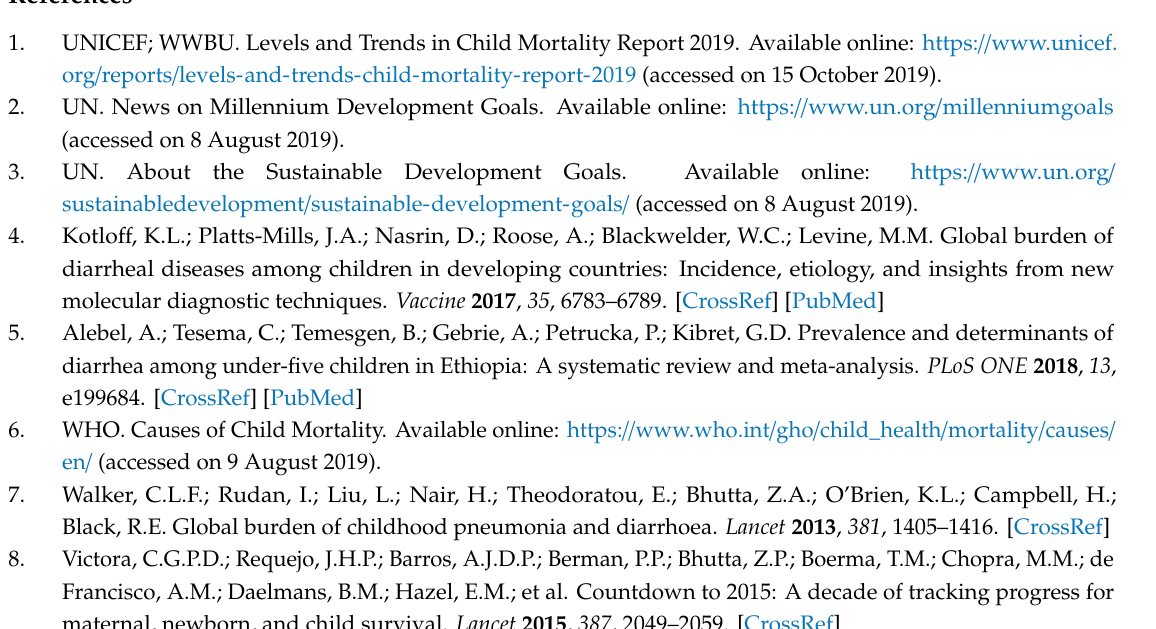
Figure S1: Posterior median (I) and SD (II) of the term δ it for spatial-temporal random e ff ects in Nepal, stratified by the survey years, Figure S2: The temporal change of δ it . (I-A) and (I-B) present the median of posterior distribution of OR between the survey year 2011–2006 and 2016–2011, respectively. (II-A) and (II-B) present the probability of OR > 1 for the survey year 2011–2006 and 2016–2011, respectively, Table S1: Prevalence and 95% confidence intervals of observed prevalence in each district by the survey year, Table S2: Spatial autocorrelation analysis of the median of posterior distribution of δ jt , categorized by the survey year, Table S3: Posterior summaries of the final Bayesian spatial-temporal model parameters of full